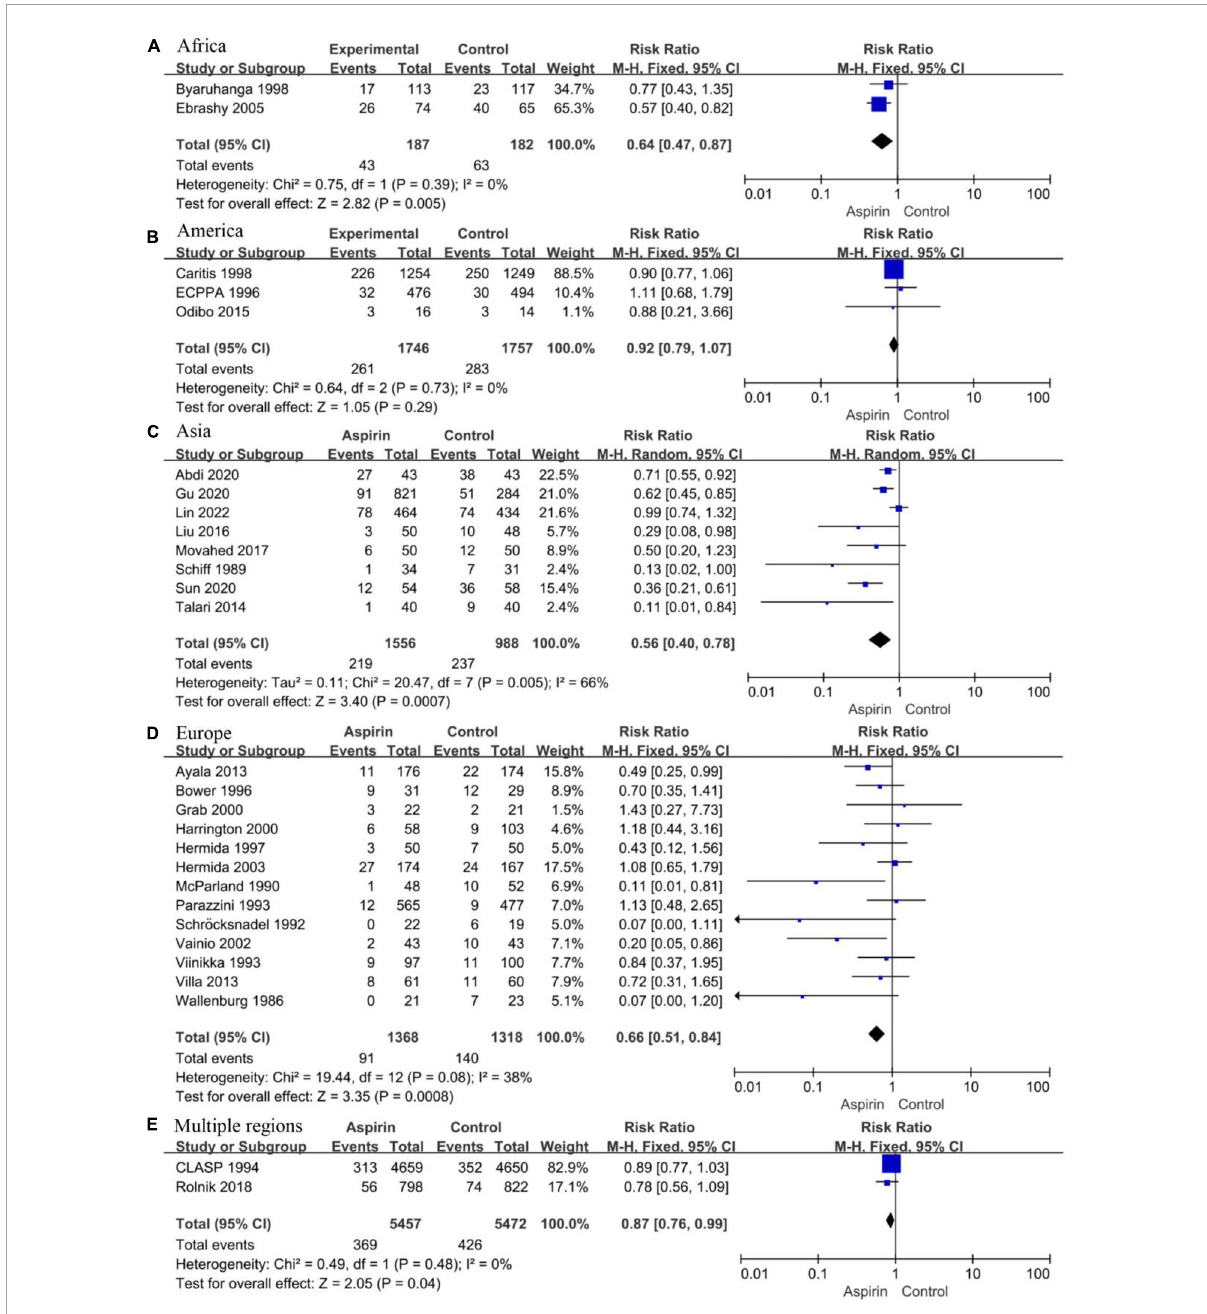
FIGURE7 Forest plot showing subgroup analysis by study region. (A) Africa. (B) America. (C) Asia. (D) Europe. (E) Multiple